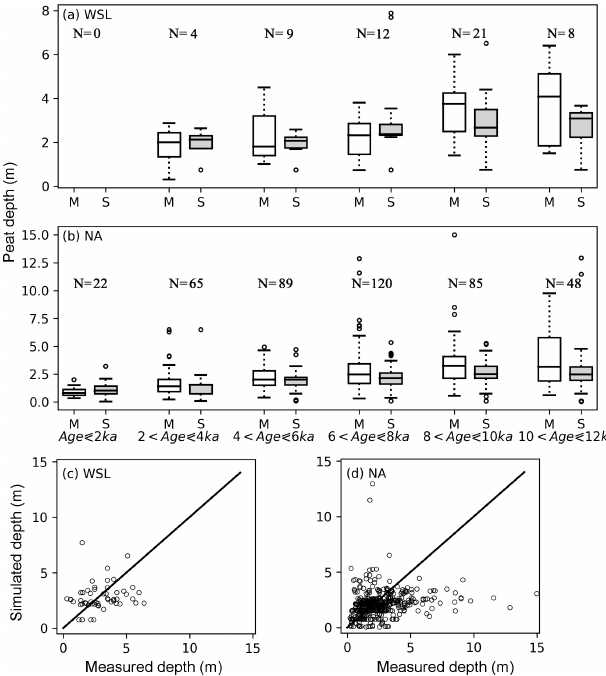
Figure 10. (a, b) Measured (M) and simulated (S) mean peat depth at the West Siberian lowlands (a) and North America (b) , grouped according to the mean age of peat cores. Measured peat cores are from Gorham et al. (2012) and Kremenetski et al. (2003). The hori- zontal box lines: the upper line – the 75th percentile, the central line – the median (50th percentile), the lower line – the 25th percentile. The dashed lines represent 1.5 times the interquartile range (IQR). The circles are outliers. Number of included grid cells in each age group is indicated by N . (c, d) The scatter plot of measured and simulated peat depth for the West Siberian lowlands (c) and North America (d) . For a grid cell that has multiple measured peat cores, the median depth of all measurements is plotted against the simu- lated depth in the scatter plot.